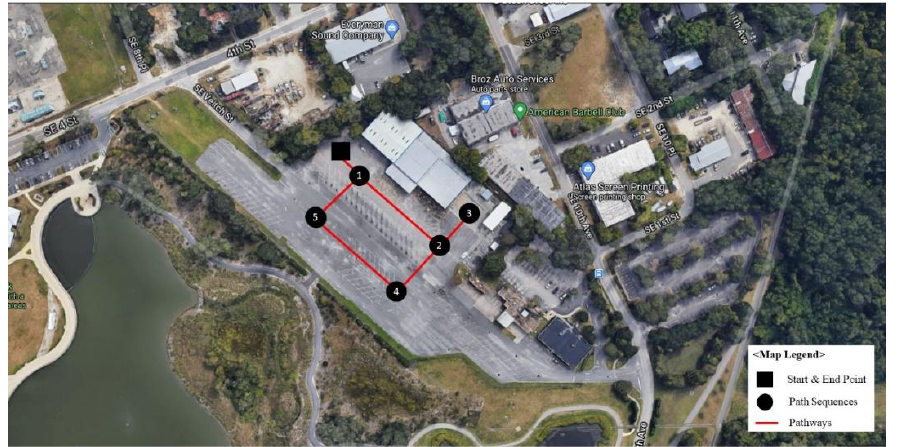
Figure 4. Shuttle Route: Ten-minute automated shuttle ride followed the sequences (1 to 5) of the pathways (red).